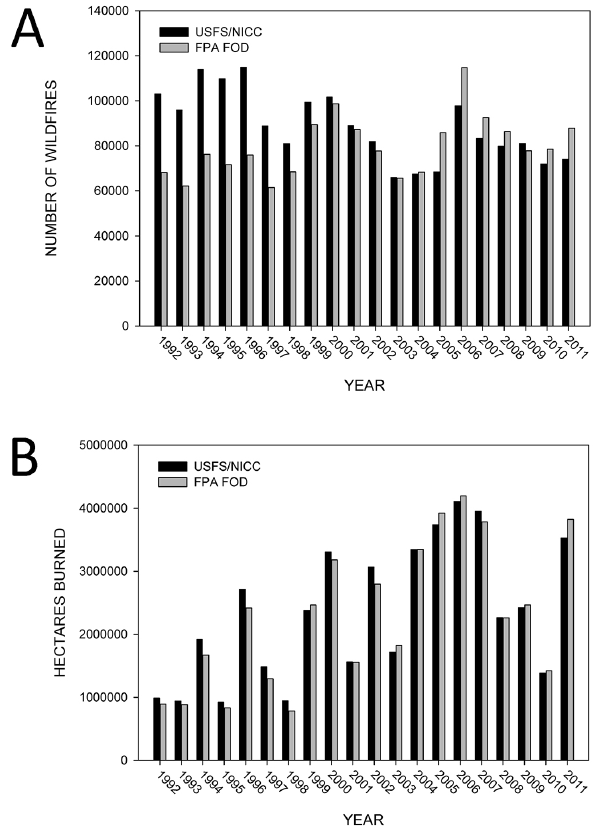
Figure 4. Comparison of wildfire (A) numbers and (B) area burned (hectares) in the US, 1992–2011, from published national estimates (USFS / NICC) and from the FPA FOD. Estimates from the USFS wildfire activity statistics reports were used for 1992–1997 refer- ence numbers, while those from NICC Predictive Services annual reports were used for